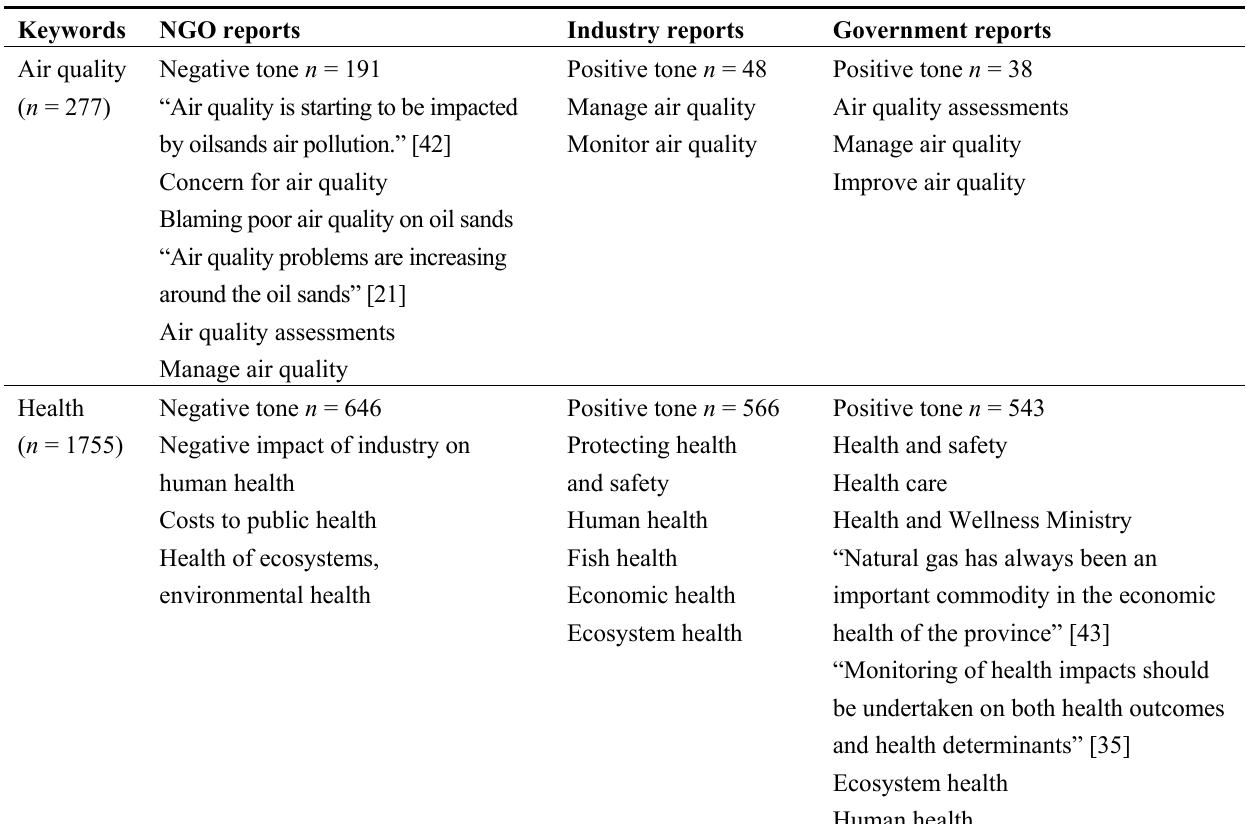
Table 5. Keywords with negative tone in NGO reports and positive tone in industry and government